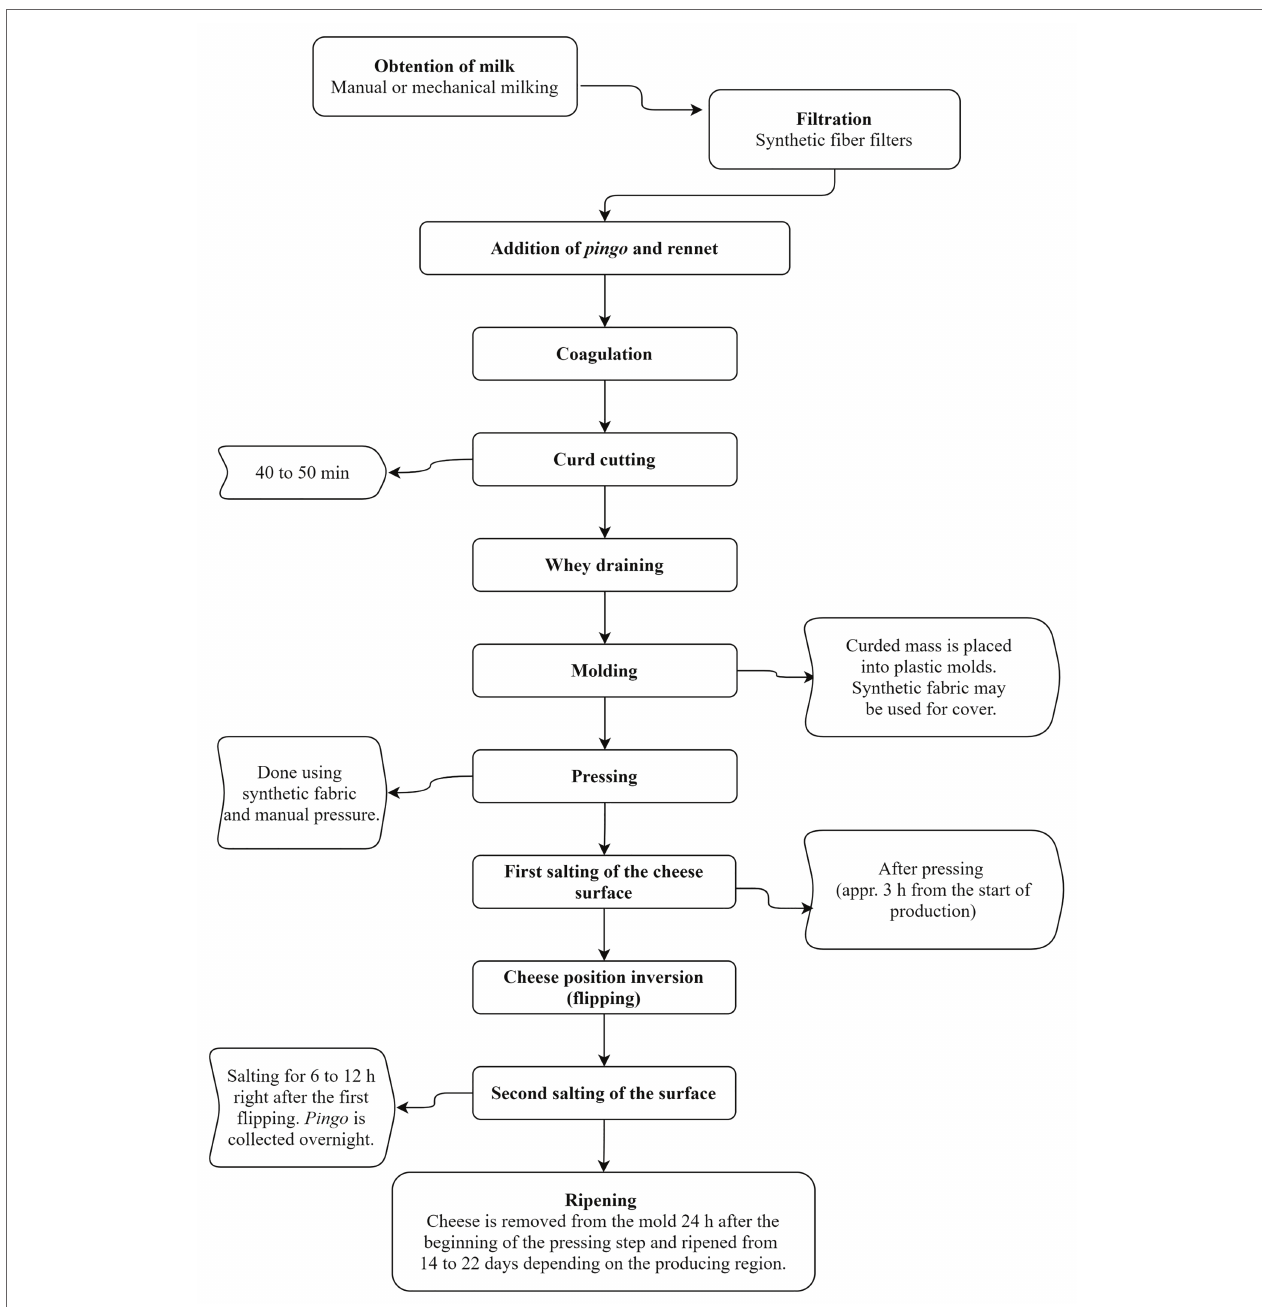
FIGURE 2 | Flowchart of Minas artisanal cheese production. Pingo is a type of endogenous starter culture composed of fermentative microorganisms. It is collected from freshly manufactured cheeses during the molding stage, and it is used to make the next day’s batch (backslopping